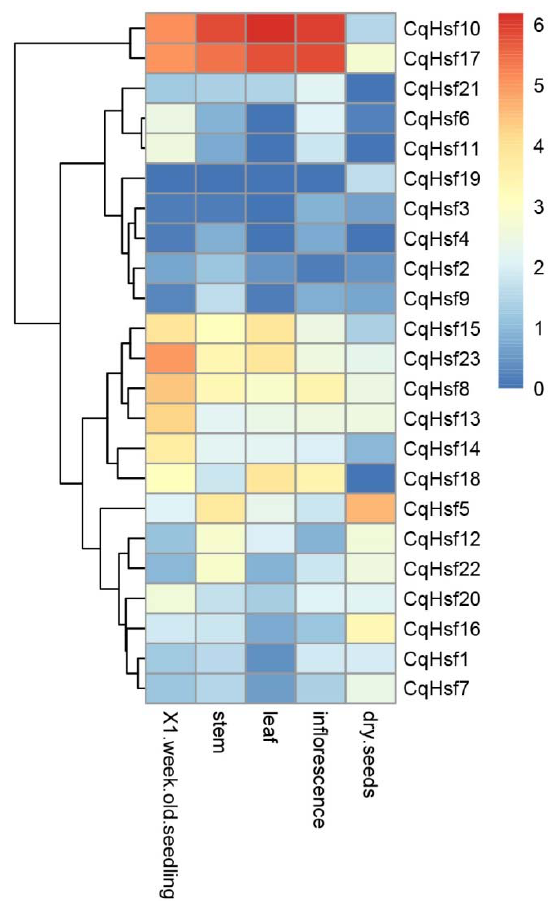
Figure 4. Expression patterns of CqHsf genes in five different tissues. Red bars represent high expression levels and blue bars represent low expression levels.